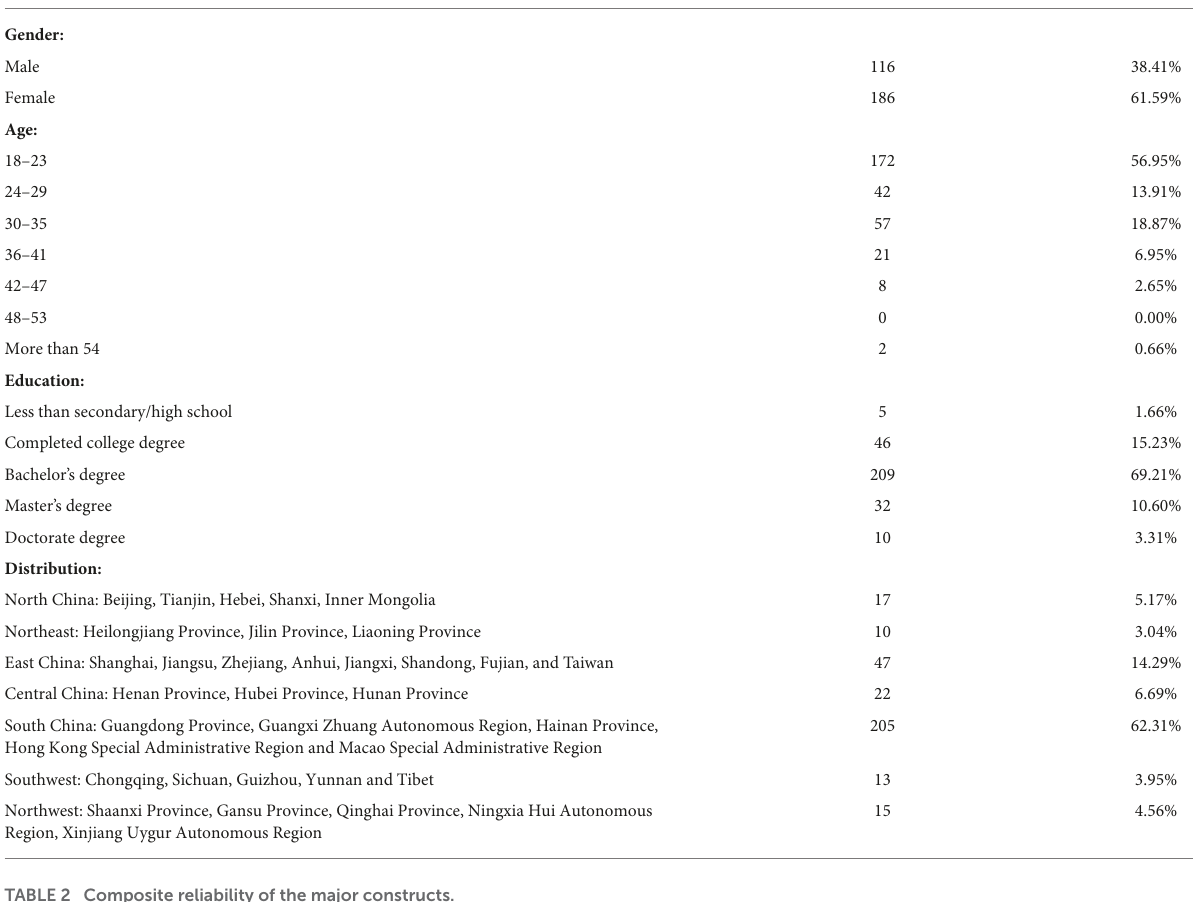
TABLE 1 Demographic profiles of respondents. Characteristics